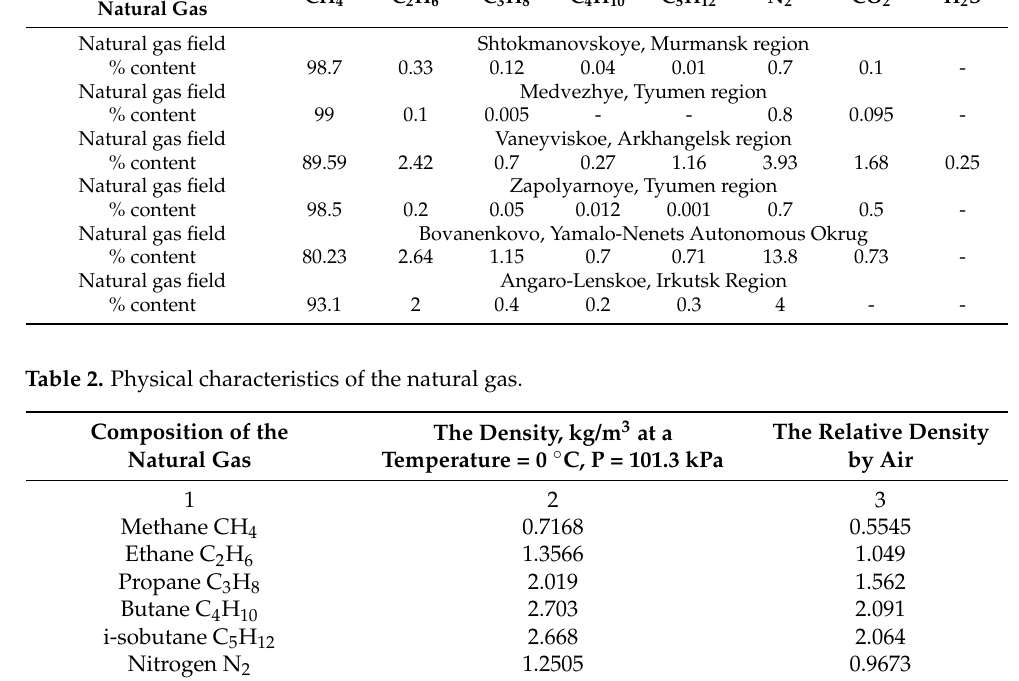
The Density, kg/m 3 at a Temperature = 0 ◦ C, P = 101.3 kPa